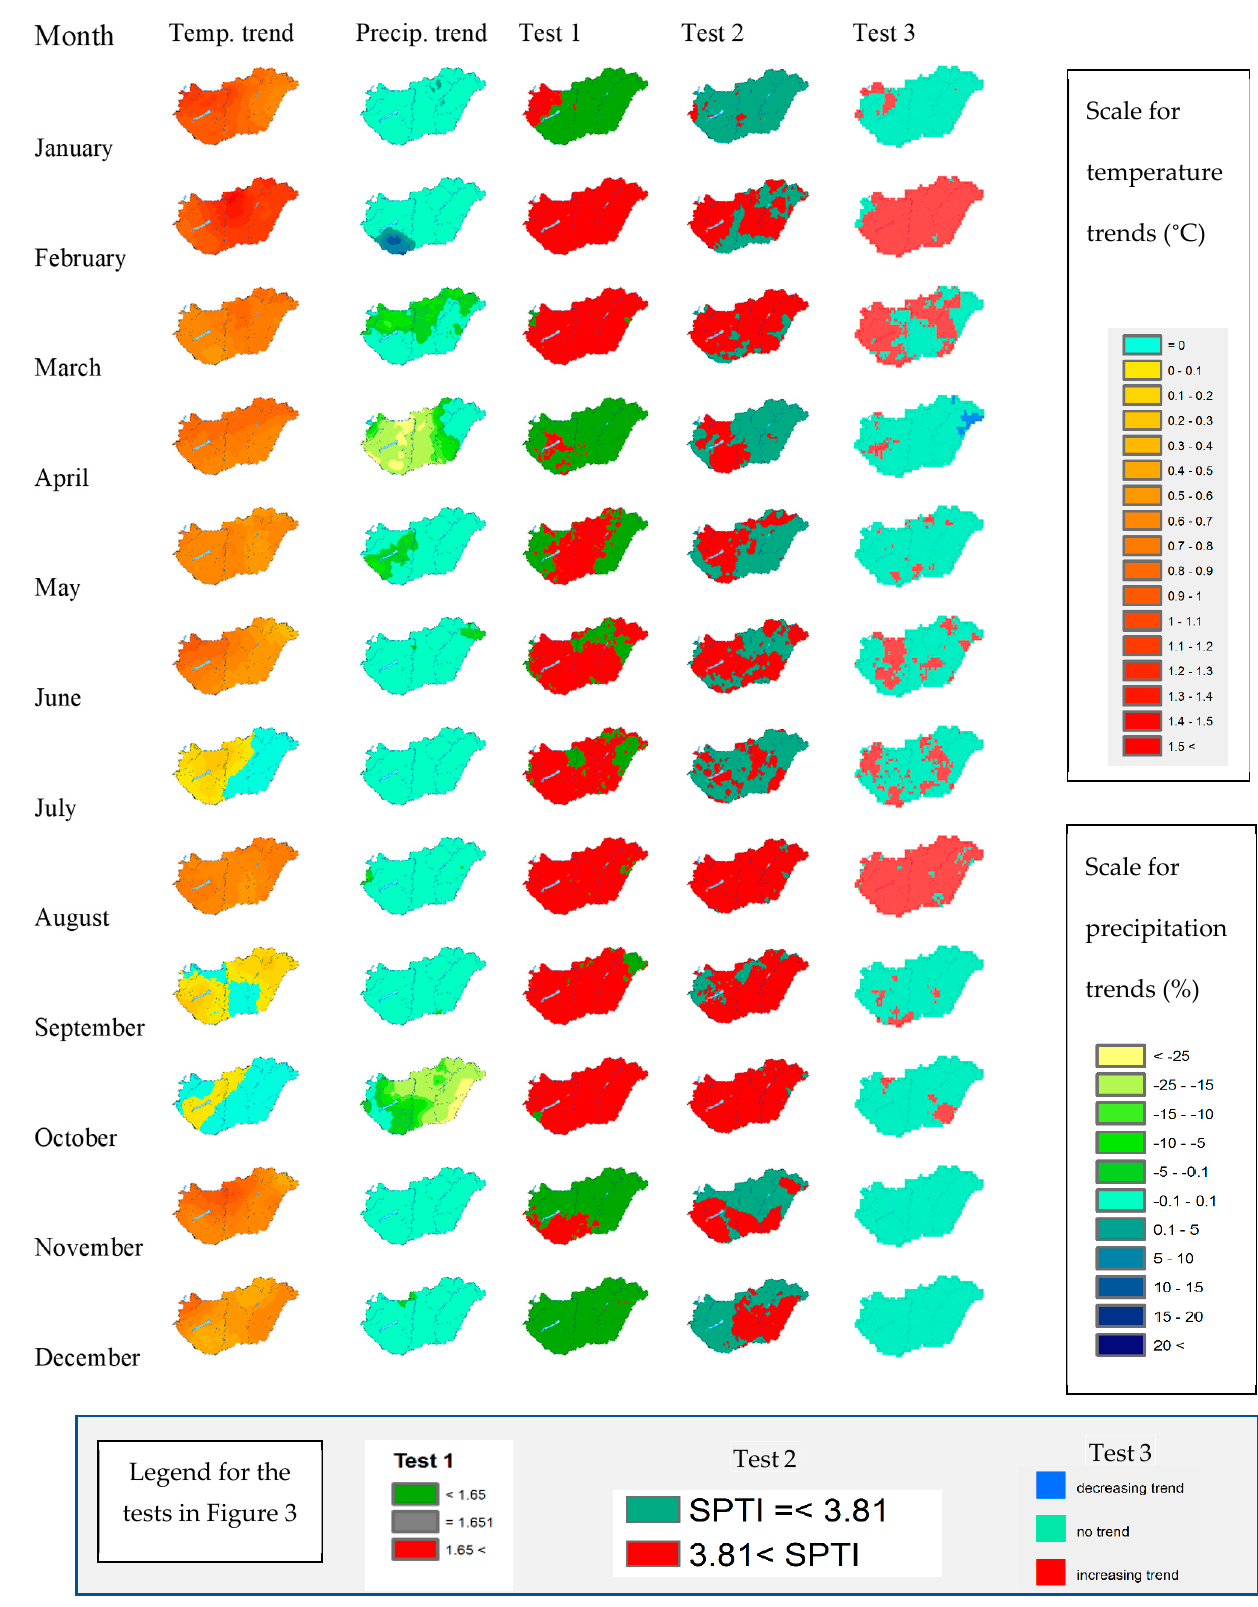
Figure 3. Temperature and precipitation trends. Test1, Test2 and Test3 results per month for the period 1871–2020.